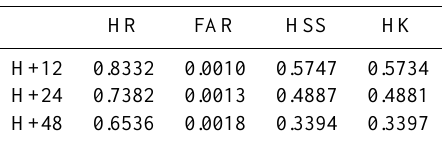
Table 1. Skill score values (HR, HSS, and HK; perfect score: 1, FAR, perfect